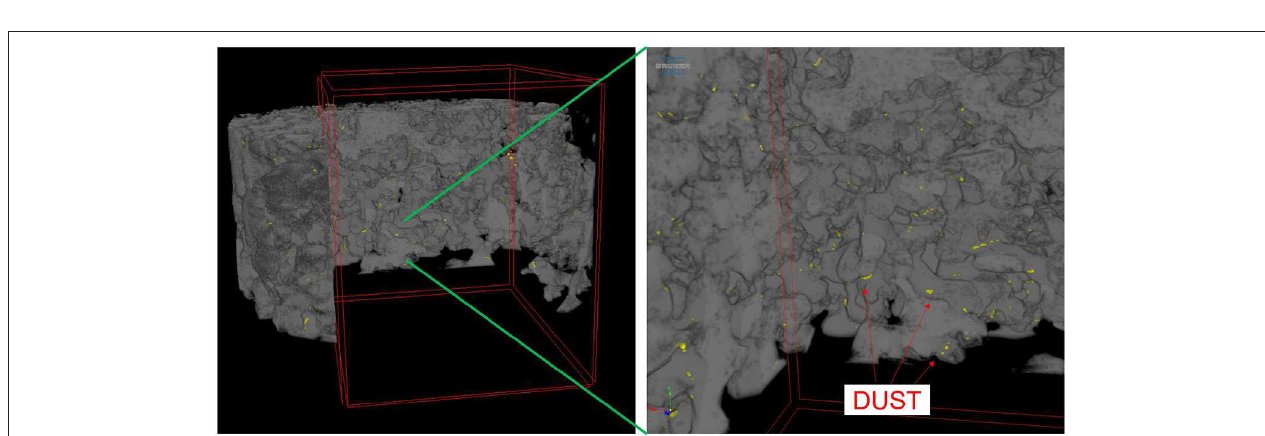
FIGURE 6 | Three-dimensional micro-CT image of dust particles within snow matrix, showing the dust located on the surface of snow grains. In the figure, dust is yellow and the snow grains are gray.